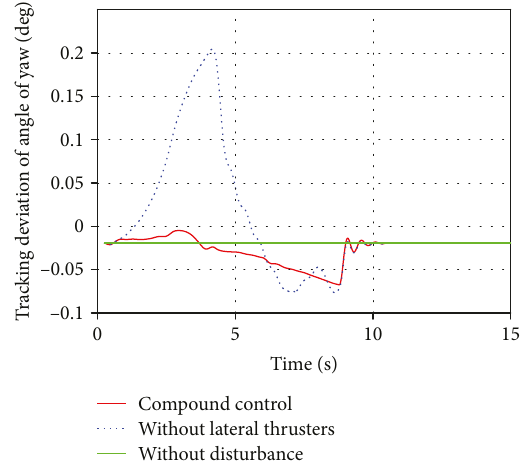
Figure 3: Tracking deviation of angle of yaw in the initial stage of launch.